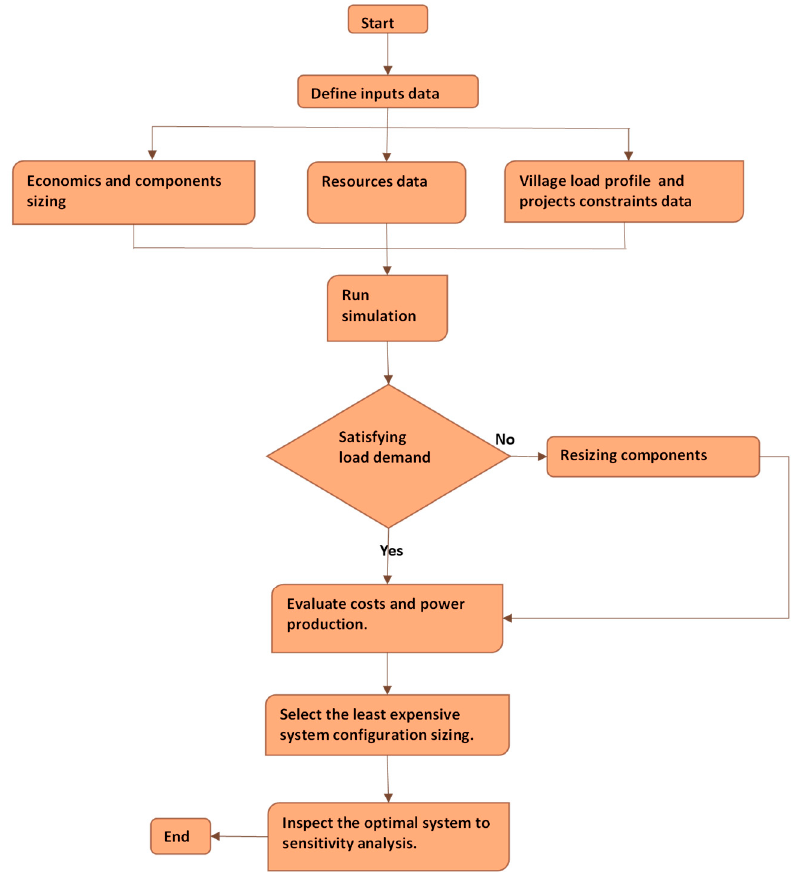
Figure 8. Hybrid system economic evaluation flowchart.